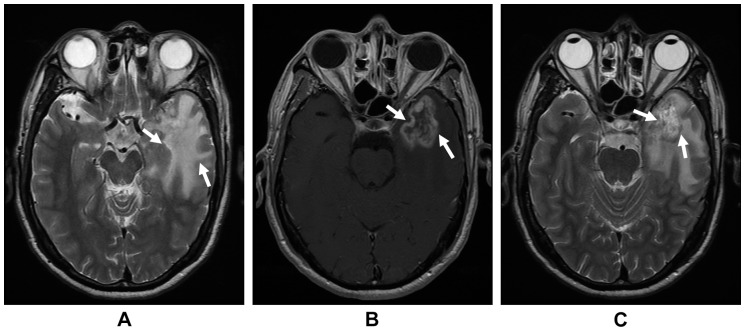
Representative MRI of patients with radiation-induced temporal lobe necrosis.(a) the T2-weighted axial image shows a finger-like lesion of increased signal intensity (between the arrows); (b) the post-contrast T1-weighted axial image shows a lesion with necrosis and heterogeneous signal abnormalities (between the arrows); (c) the T2-weighted axial image shows an oval cyst with high T2 signal intensity (between the arrows).